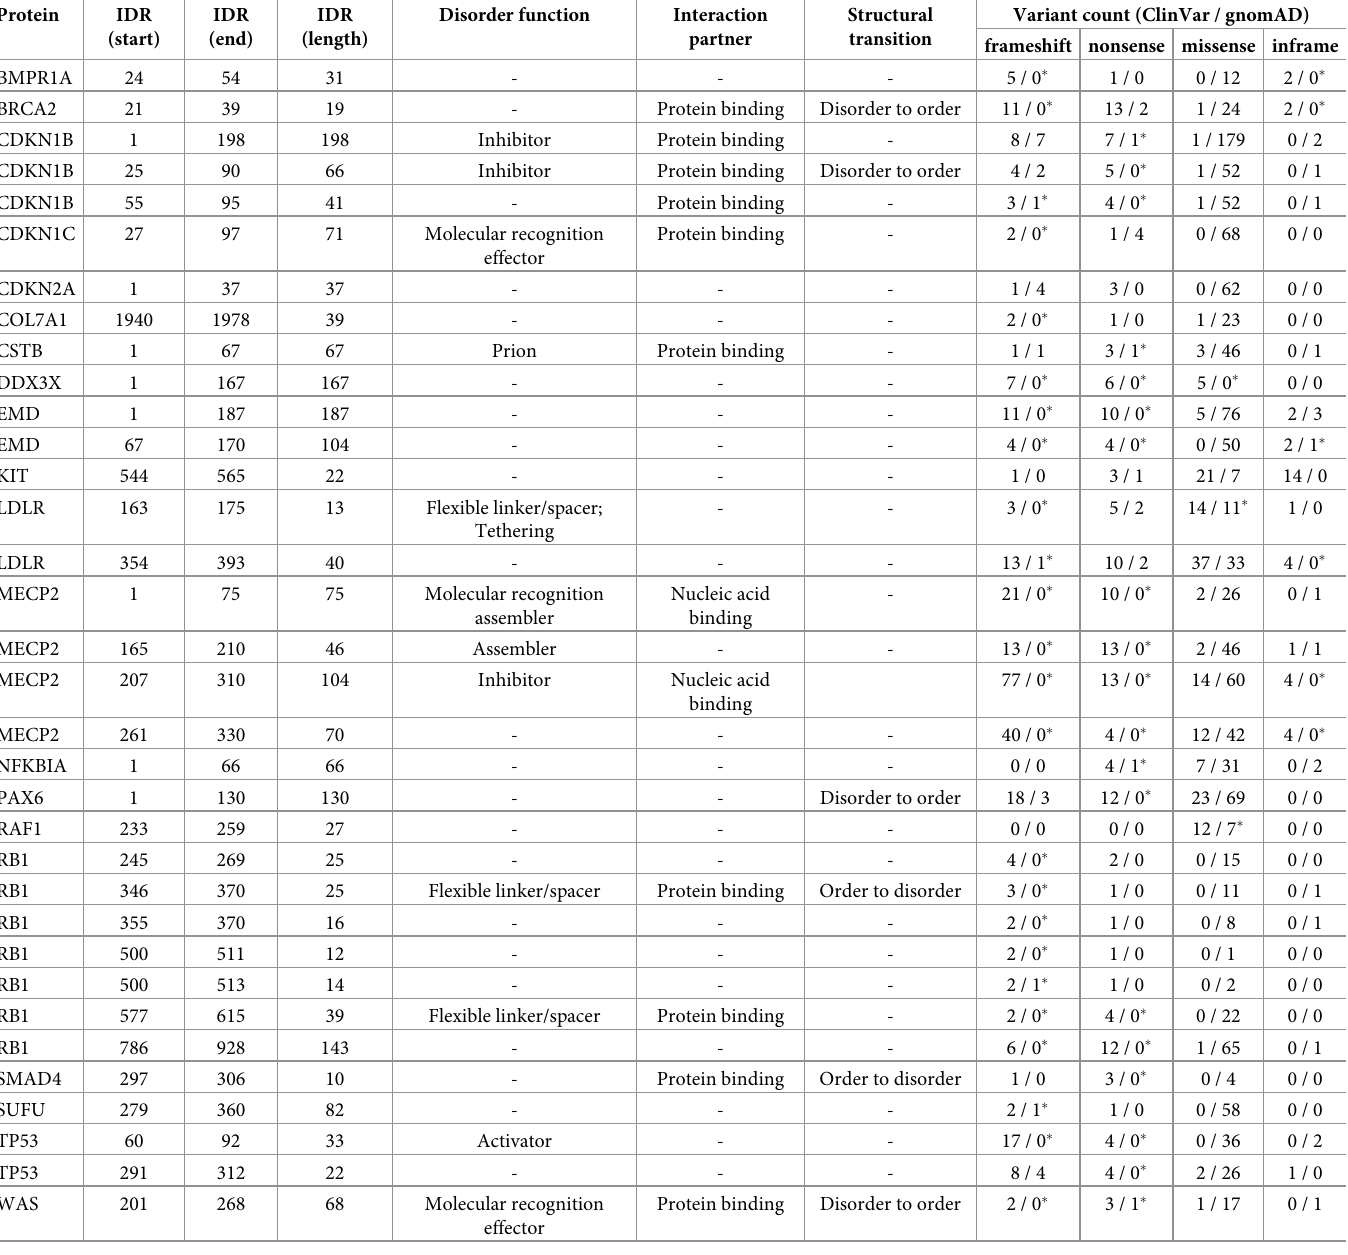
Table 1. Intrinsically disordered regions (IDRs) that are intolerant to mutations and their categories. Protein IDR